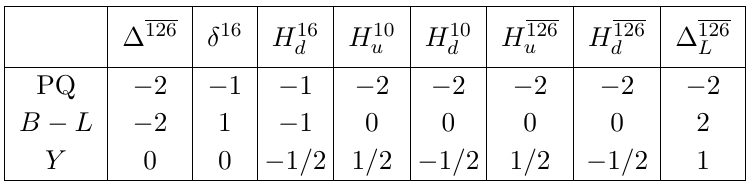
Table 2 . Global (PQ) and local ( B physical axion